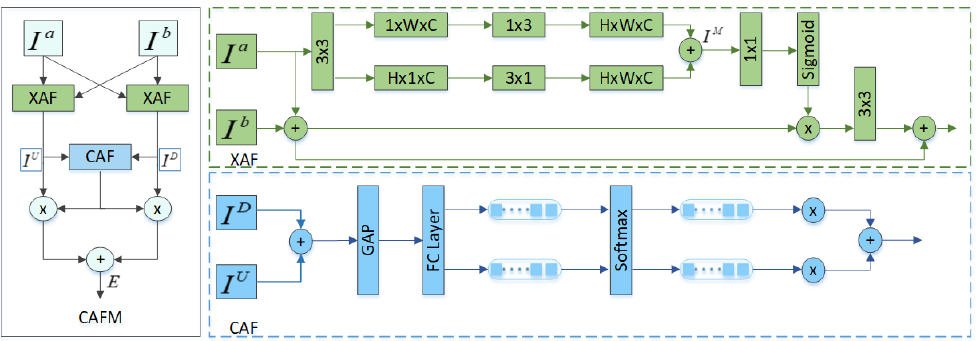
Figure 4. CAFM is Cross-Attention Fusion Module, XAF is cross-attention fusion, and CAF is Channel Attention Fusion. GAP denotes global average pooling; FC Layer is fully connected